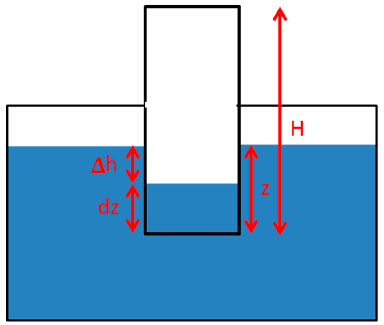
Figure 6. Scheme of the air pressure chamber inside the water.